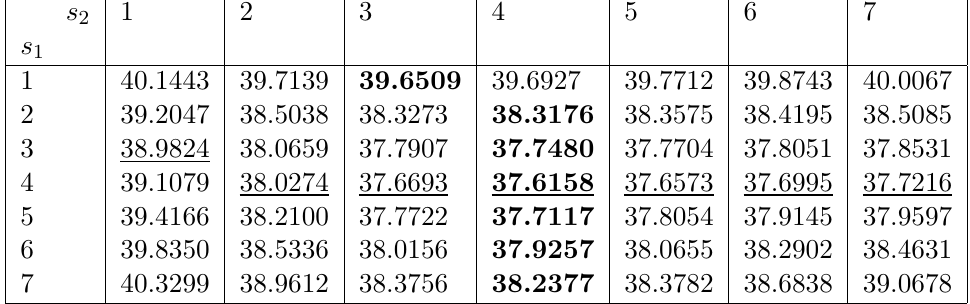
Table 1: Total expected cost